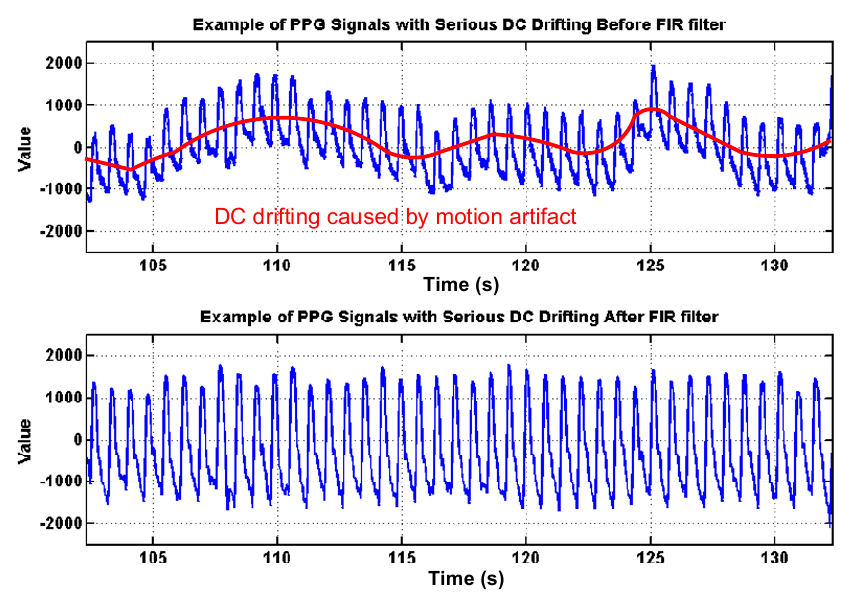
Figure 9. Effects of the proposed finite impulse response (FIR) filter to cancel the DC drifting caused by low-frequency motion artifacts, such as vasomotion, respiration.